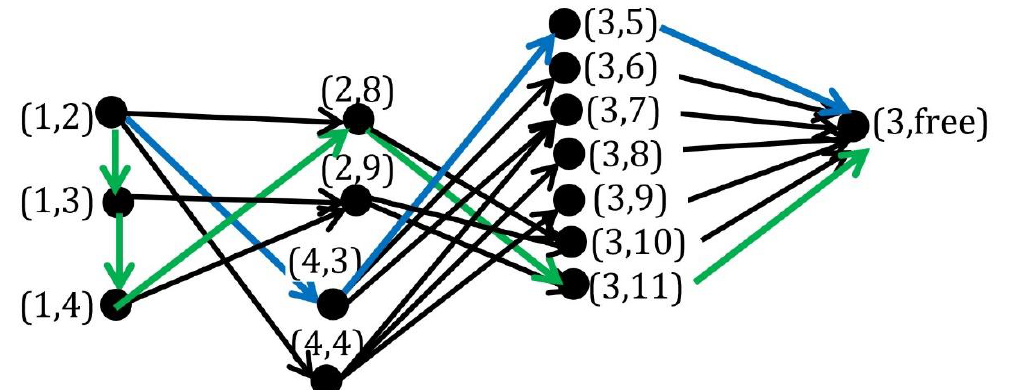
Figure 8. Minimal fuel consumption (green) and minimal time/ schedule penalty (blue) space-time routes Enumerated space-time-feasible trajectories for four-node example in incident scenario, with Pareto optimal solutions highlighted Space-time nodes